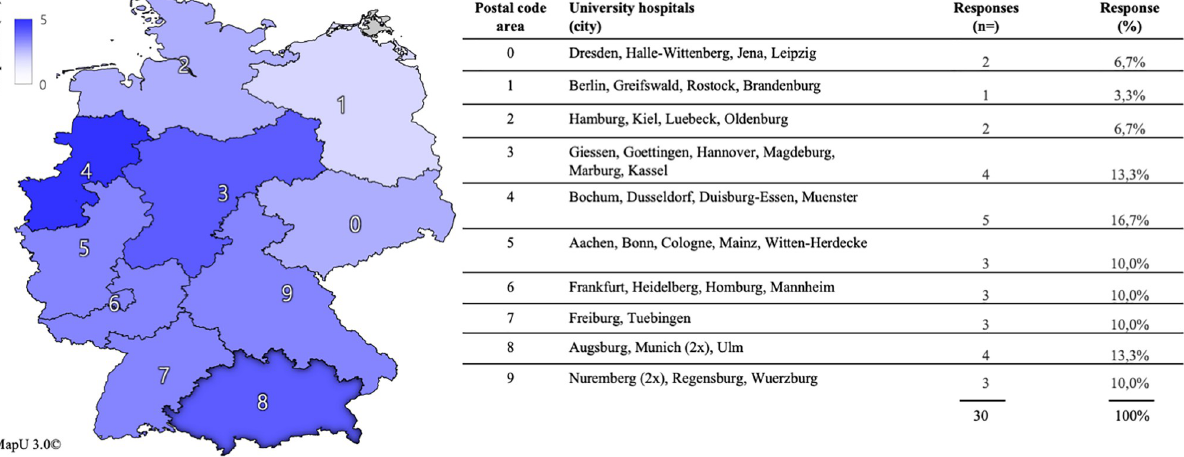
Table 1. Evaluation of the implementation of e-learning in medical teaching during the COVID-19 pandemic. The implementation of the e-learning offering was swift and uncomplicated.